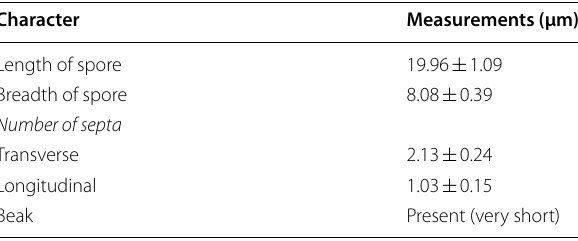
Table 1 Spore characters of Alternaria alternata VLH1 (Average of minimum 30 spores)